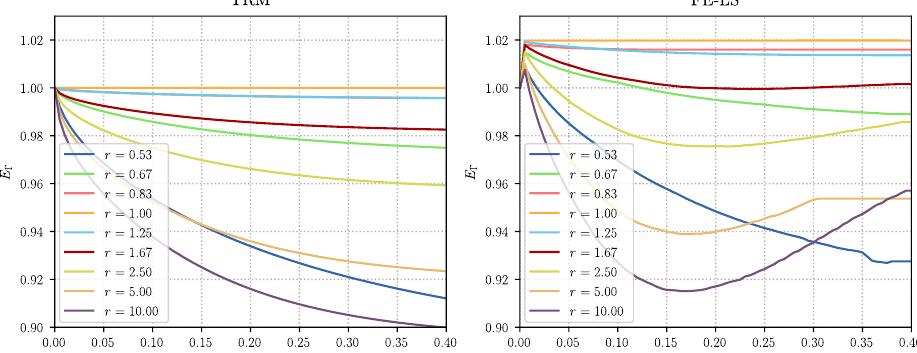
Figure 7. Triple junction test case: evolution of the normalised total grain boundary energy E Γ for the ( left ) TRM and ( right ) LS-FE models. The plotted data for the LS-FE model was taken from